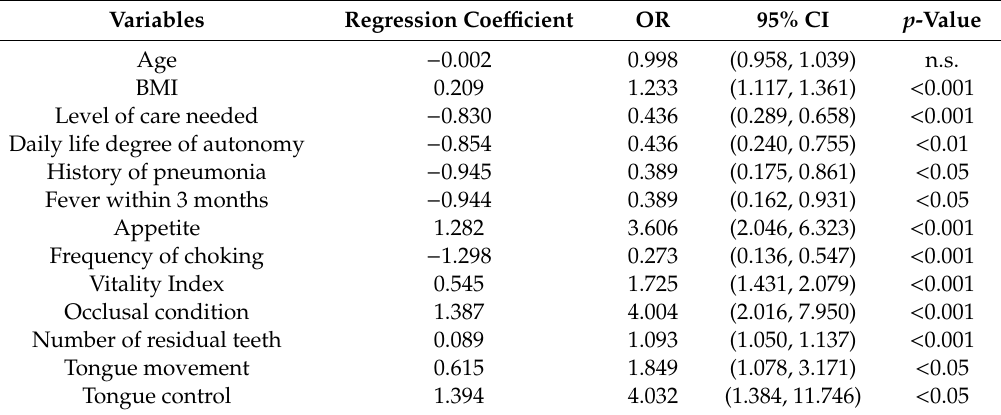
Table 4. Univariate logistic regression analysis.